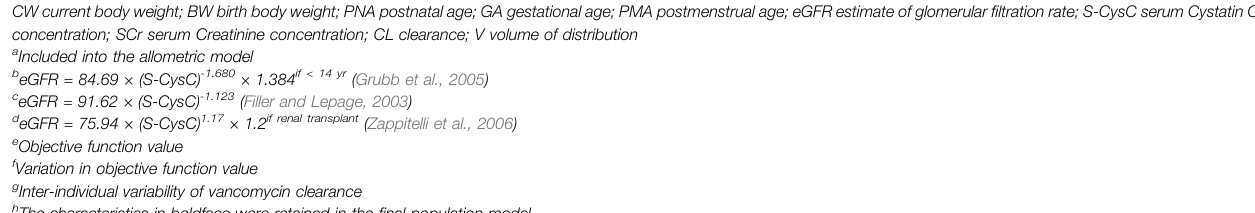
Figure S2 ). The median parameter estimates resulting from the bootstrap procedure closely agreed with the respective values from the fi nal model ( Table 3 ). The mean and variance of NPDE were 0.03 (Wilcoxon signed rank test p (cid:2) 0.89) and 1.05 (Fisher variance test p (cid:2) 0.70), respectively. Further Exploration of Differences Between SCr and S-CysC in Respect to Study Purpose